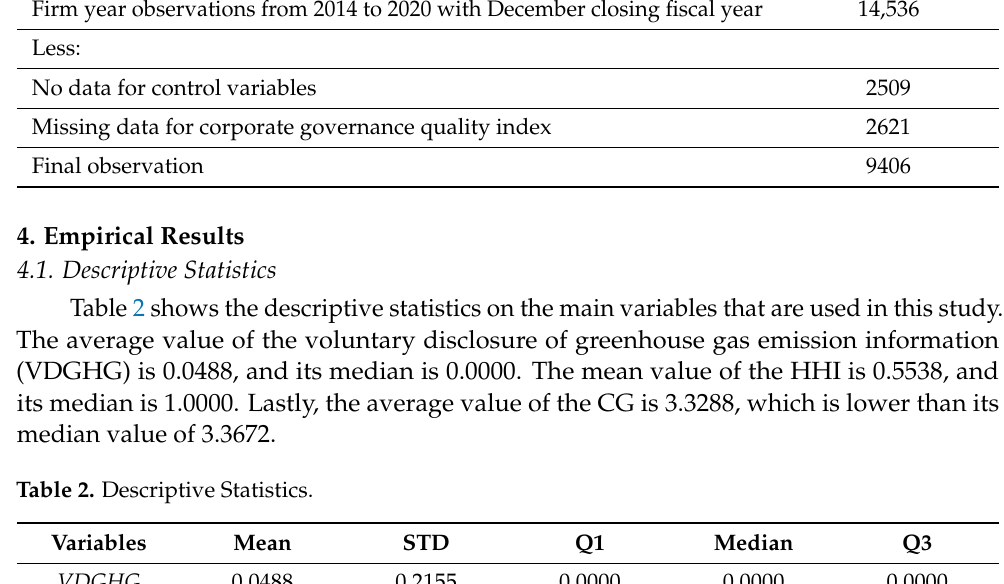
Table 1. The Data Selection Process.